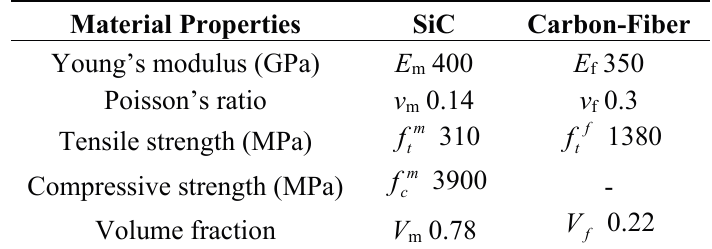
Table 2. Properties of the component materials of C/SiC